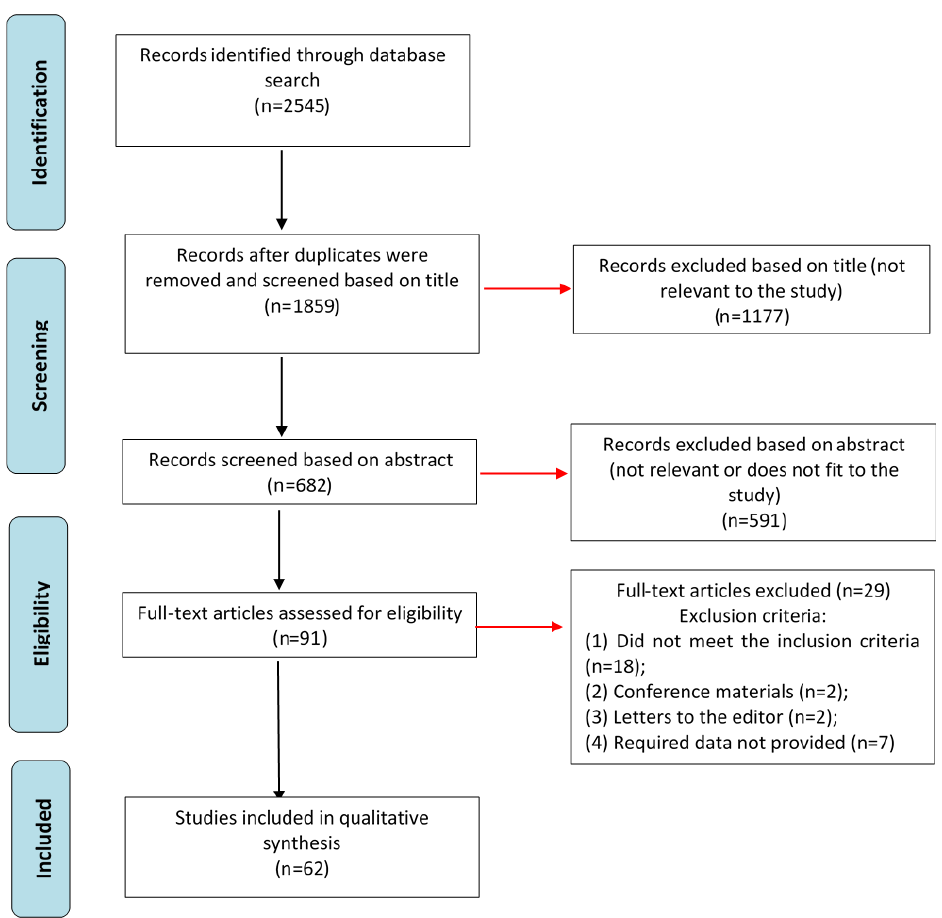
Figure 1. Search strategy and selection of literature for inclusion in the systematic review.